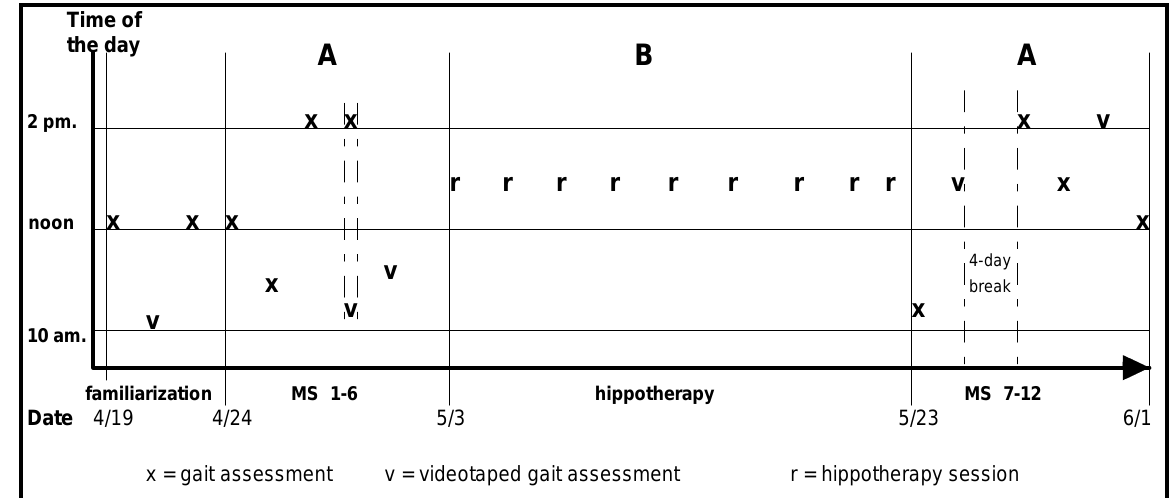
Figure 1. Progression of the empirical phase. Gait assessments (MS 1-12) and hippotherapy program are presented based on dates and time of the